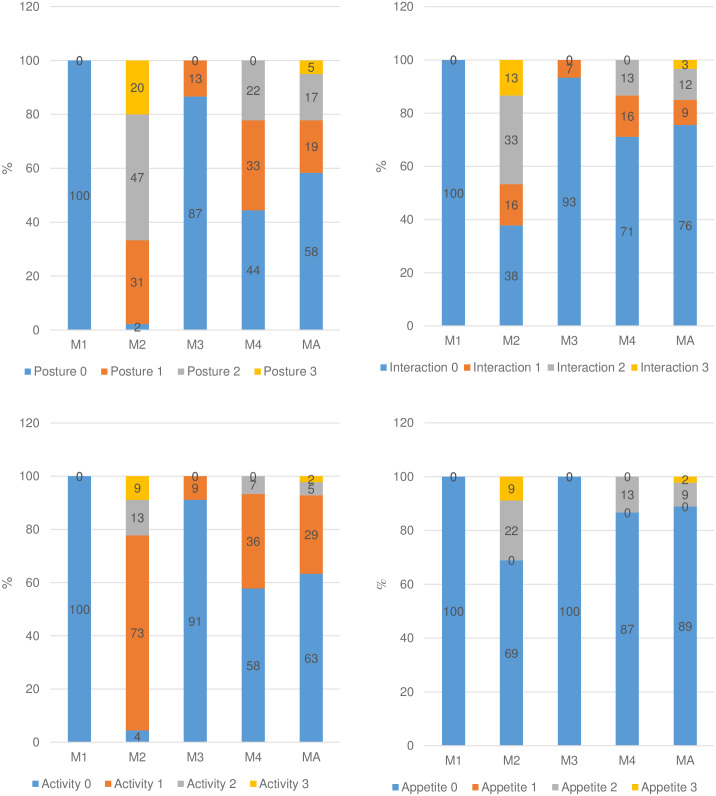
Frequency of the presence of scores of each item of the UPAPS.Legend: posture (top left), interaction and interest in the surroundings (top right), activity (bottom left) and appetite (bottom right).